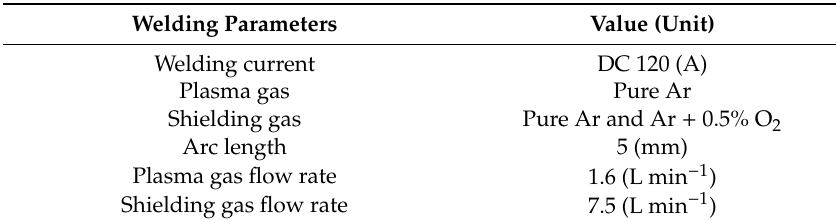
Figure 1. Experimental setup for observing the weld pool surface.